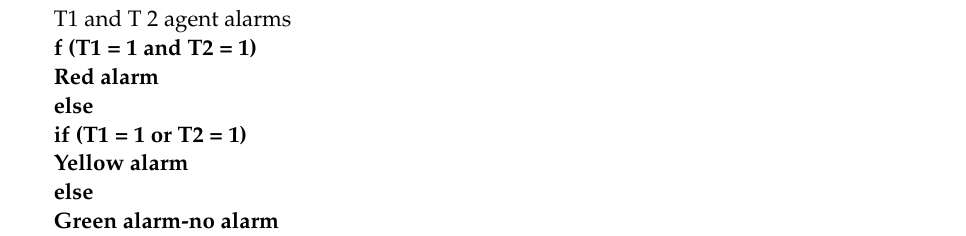
Algorithm 2: Implementation of the EIT algorithm that generates alarm